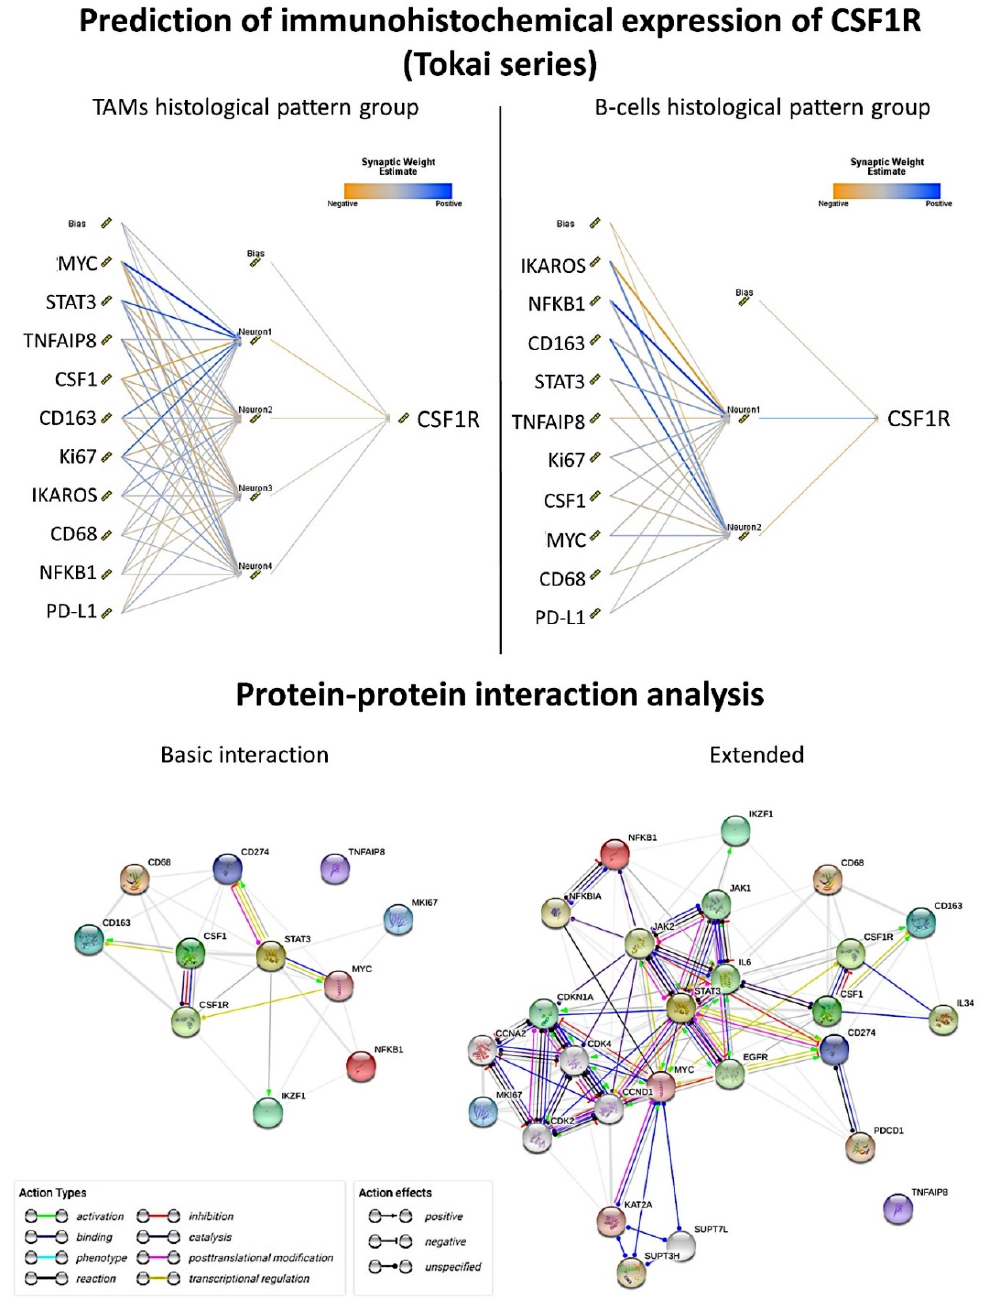
Figure 4. Prediction of the immunohistochemical expression of CSF1R in each of the histological expression groups by a set of 10 markers using Artificial Neural Network (Tokai series). In each of the CSF1R histological expression groups, the expression of CSF1R could be predicted by modeling using a multilayer perceptron analysis. According to their importance, the markers are ranked as the most important in the model on the top, MYC proto-oncogene and IKAROS (DNA-binding protein Ikaros), and less important on the bottom (PD-L1, Programmed cell death 1 ligand 1). In order to understand how the different markers interact between them, a protein-protein interaction analysis was also perfomed, using a basic (left) or an extended network (right).